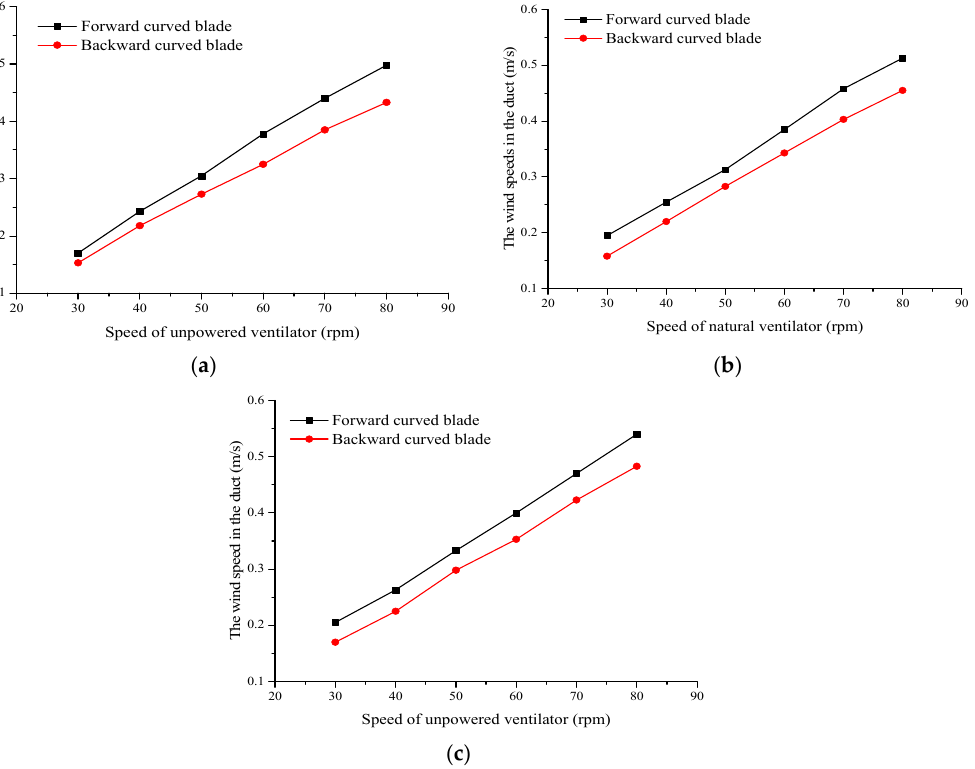
Figure 18. Relationships between wind speed in the air duct and natural ventilator speed with different blade bending directions at different testing points. ( a ) Testing point 3; ( b ) Testing point 4; ( c ) Testing point 5.